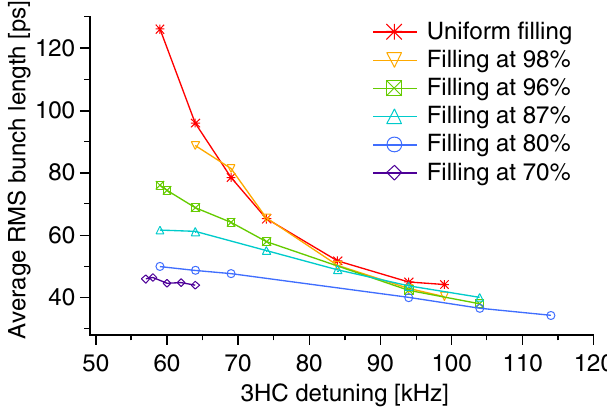
FIG. 13. (Color) Average rms bunch length along the bunch train